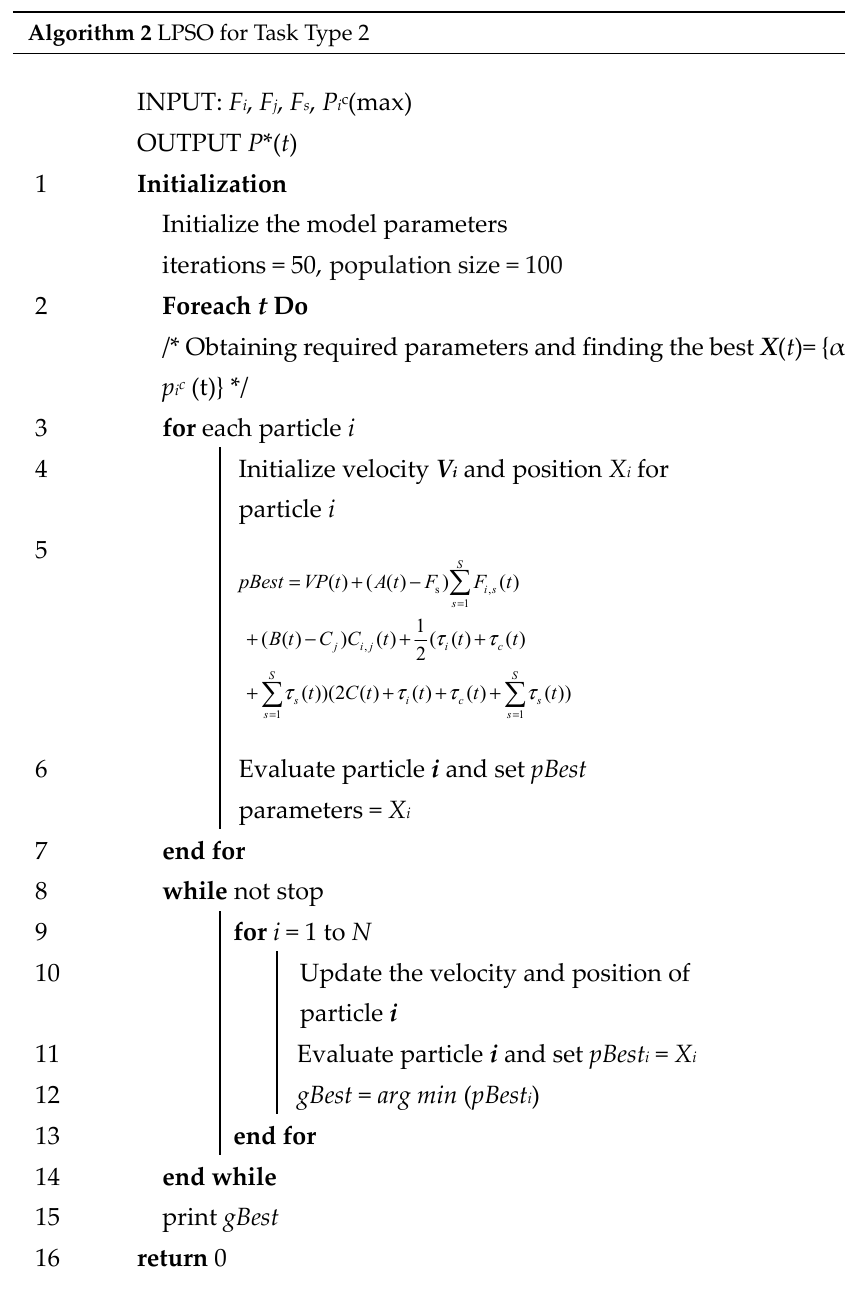
Algorithm 2 LPSO for Task Type 2